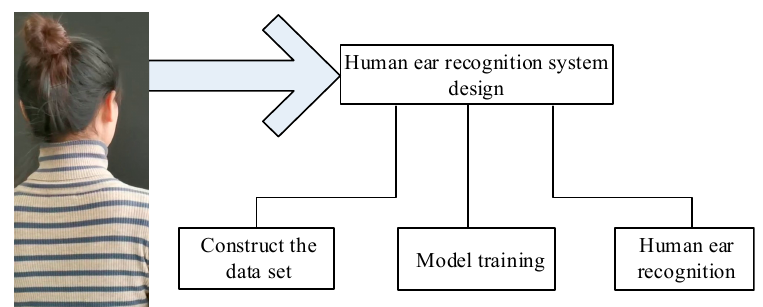
Figure 1. The block diagram of the dynamic human ear recognition system.